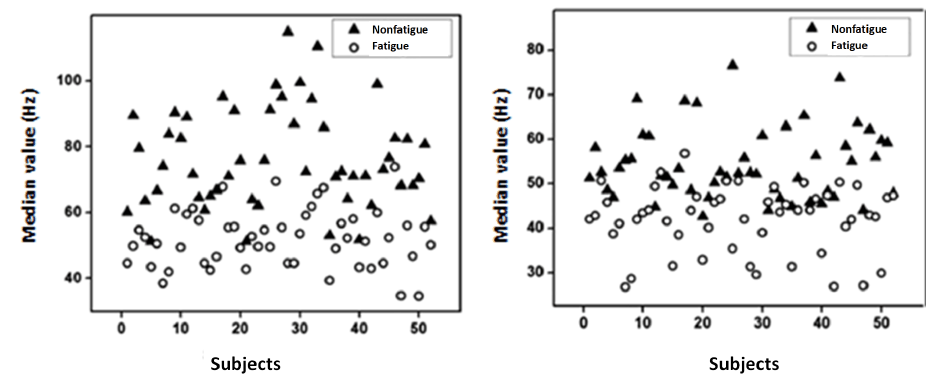
Figure 9. Median value extracted from ( a ) MNF and ( b ) MNP.